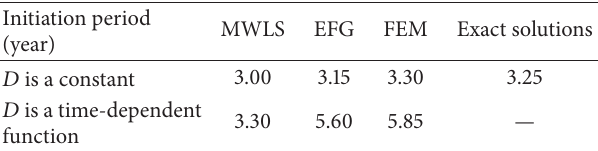
Table 6: The initiation period of corrosion as calculated by different